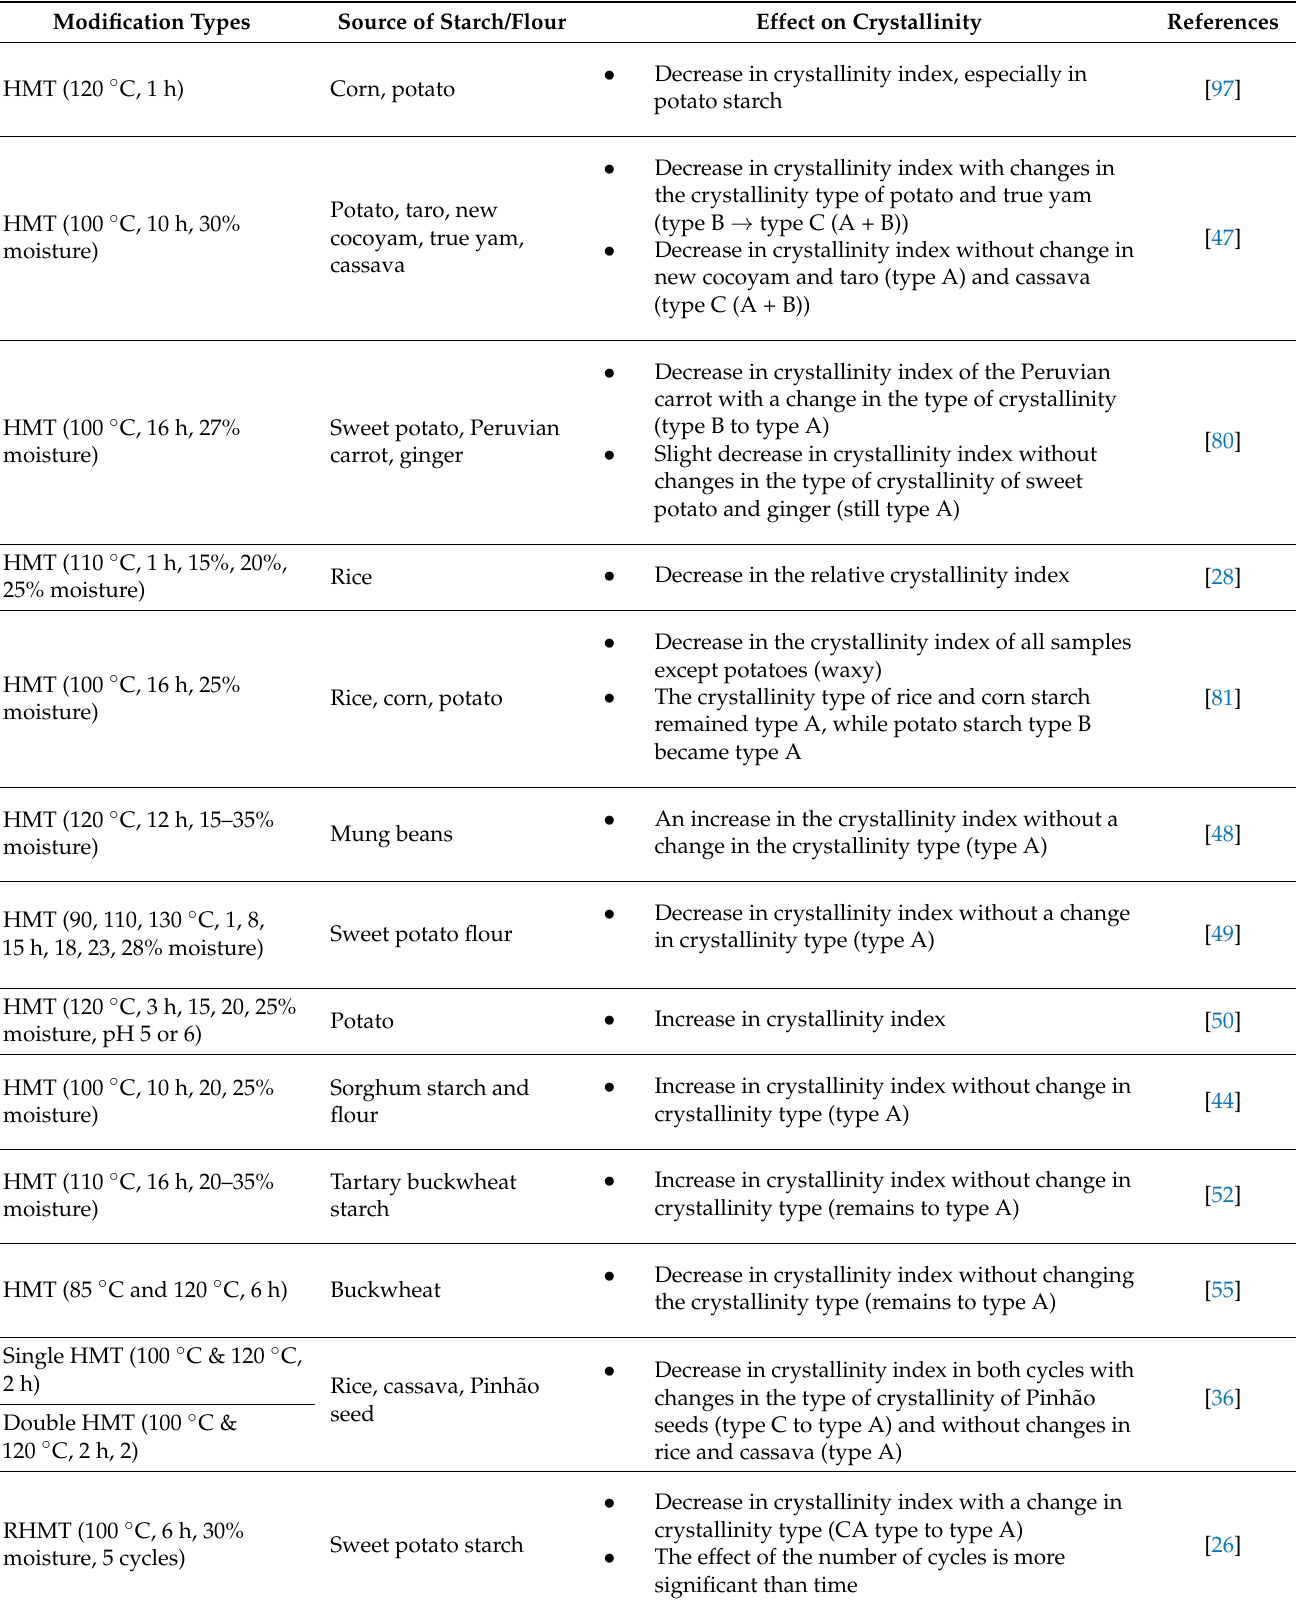
Table 4. Several studies related to the effect of hydrothermal modifications on the crystallinity of starch and